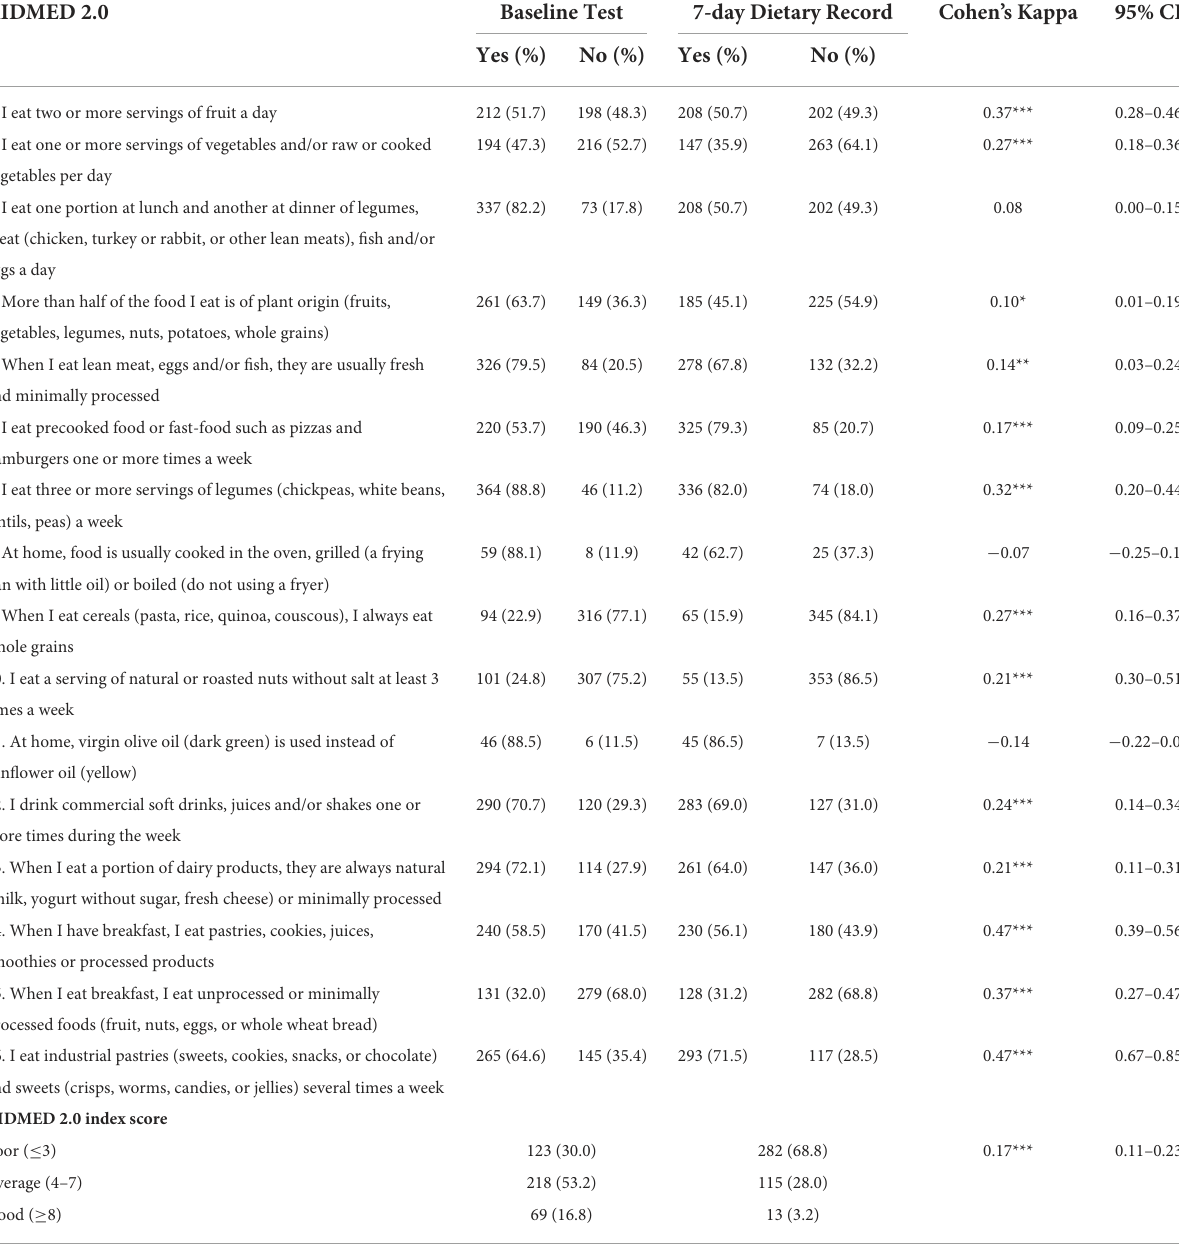
TABLE 2 KIDMED 2.0 and 7-day dietary record values of the